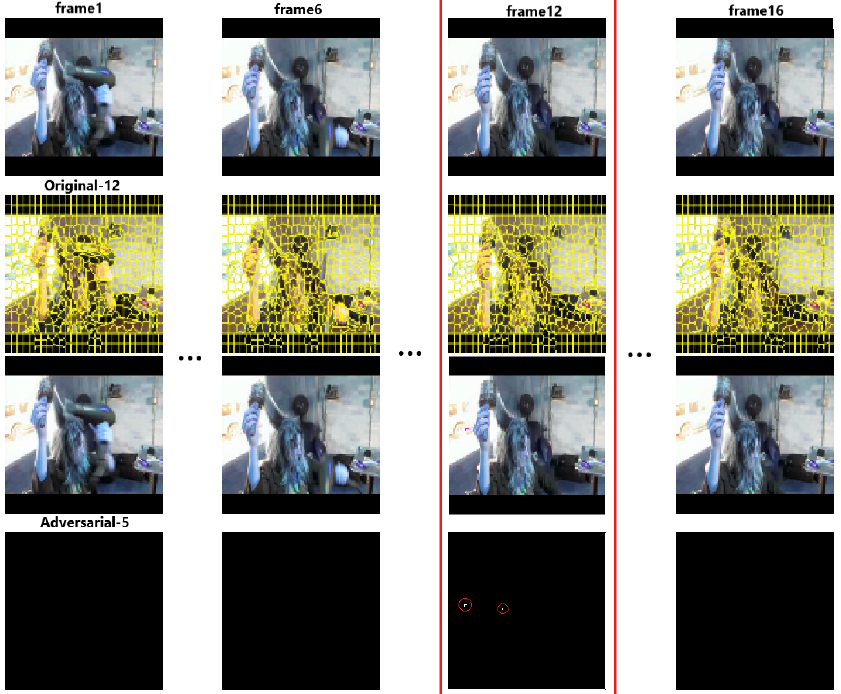
Figure 1. Examples of adversarial frames generated by our algorithm with only one frame disturbed. The first line is the original image, the second line is the image with super-pixels, the third and fourth lines are the adversarial image and difference, respectively. To see clearly, the noise is circled by red circle. The original and adversarial labels are signed under the first and third line. The label 12 is “BlowDryHair” and 5 is